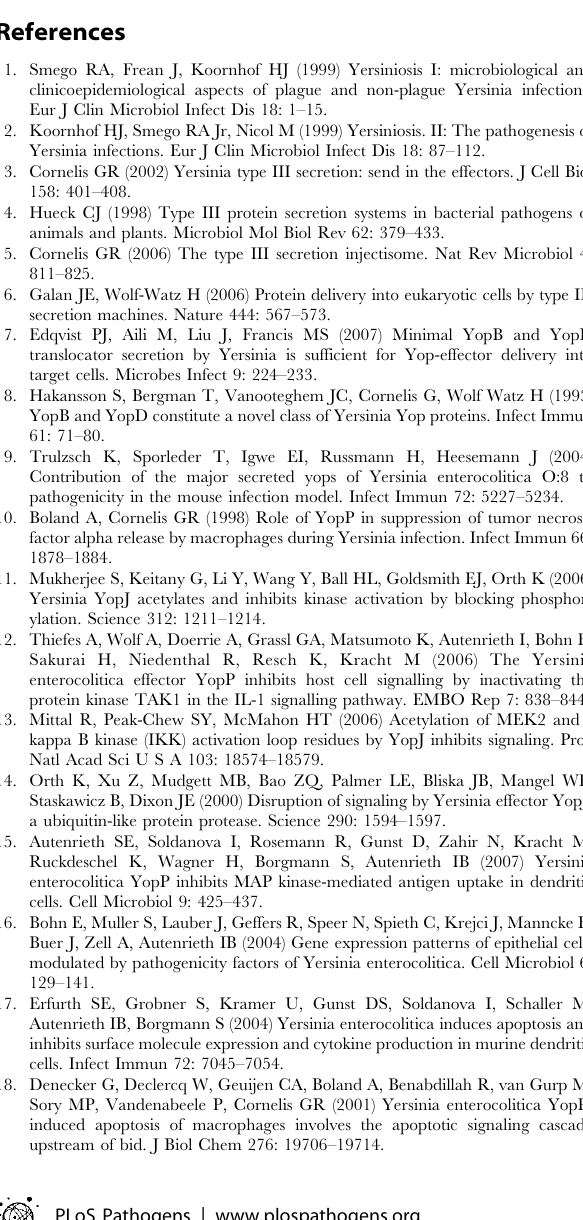
Figure S3 Analysis of activation of B cells in cell culture. Splenocytes were cultured and infected for one hour with or without E40-pBla. Cells were harvested and stained with anti- CD19-APC, anti-CD69-PE-Cy7 and MHC-II-APC-Cy7 and then incubated with CCF4. Cells were analyzed by flow cytometry. Analysis was performed in the following manner: (A) viable B cells were defined by gating using R1 & R2 & R3. (B) B cells were then further analysed for CD69 expression levels of all cells using additionally gate R5 (green + blue + cells), R6 (green + blue 2 cells) or R7 (total). Histograms for CD69 expression of uninfected or E40-pBla infected cells are shown. Numbers indicate mean fluorescence intensities (MFI) for one representative experiment. Figure S4 Infection of splenocytes of TNFR 2 / 2 , IFN- c R 2 / 2 and C57BL/6 mice in cell culture. Splenocytes were infected with indicated MOI for one hour and subsequently cells were stained with CCF4-AM and analyzed by flow cytometry. Data summarize three independent